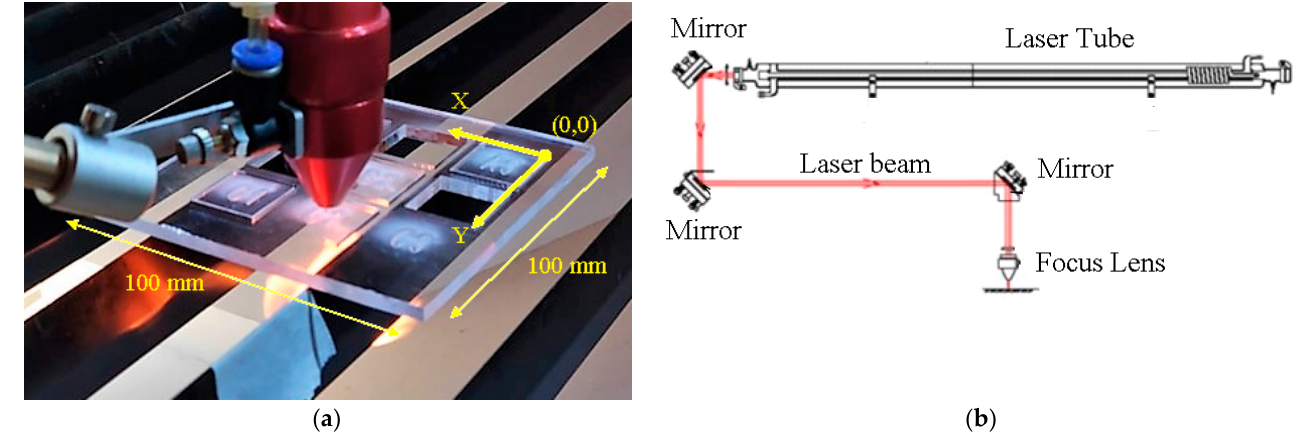
Figure 2. ( a ) The laser used for the experiments; ( b ) the laser diagram displaying the beam’s path. The cut samples have a square shape with a side of 20 mm. These were placed with a distance of 5 mm between them (see Figure 3a). All the samples were cut from a squared PMMA plate of 100 mm side with a thickness of 4 mm. For the surface roughness readings (Figure 3b), a high precision surface roughness profilometer was used (DIAVITE-DH8 ® , Figure 3c, [20]). Readings were undertaken in the middle of the cut surface. The arithmetic mean roughness ( μ m), is the most common parameter for any machining method and primarily for the product’s quality control. The arithmetic average value of filtered roughness profiles were determined from the deviations about the centre line within the estimation length.